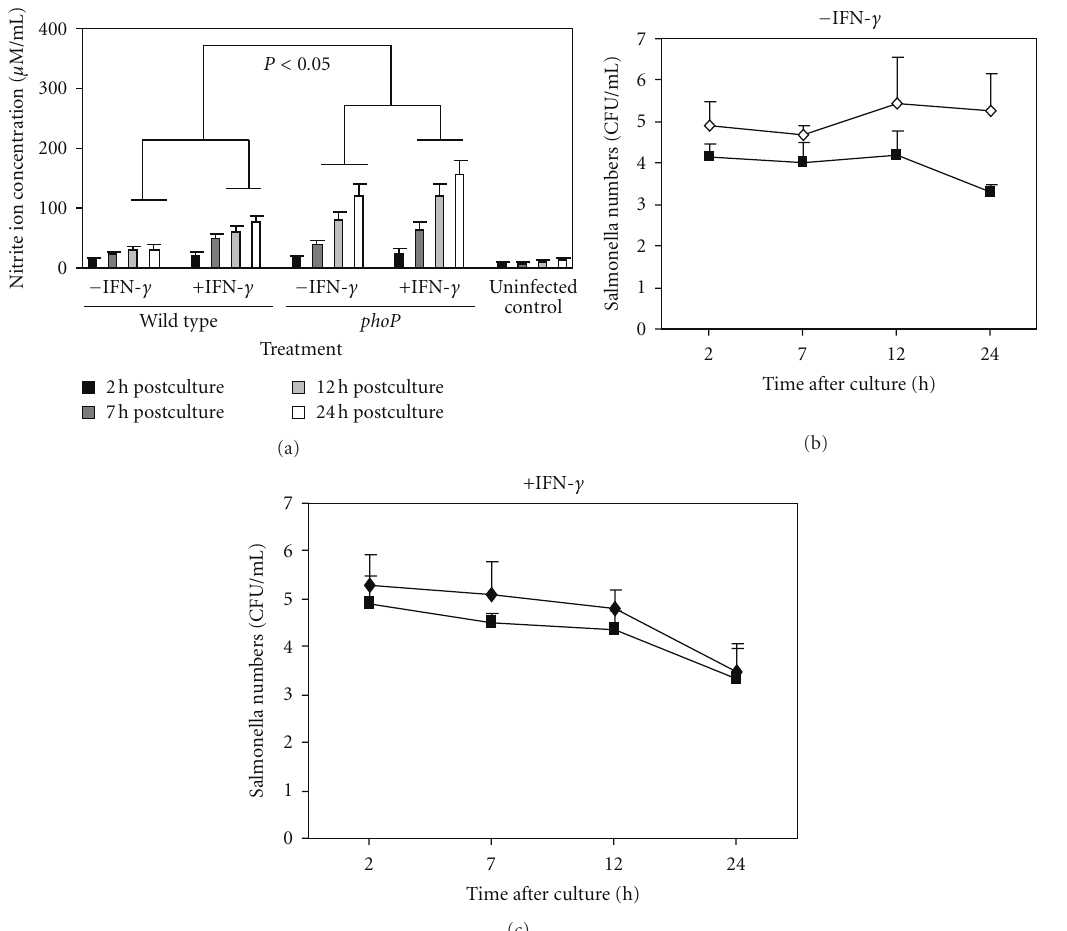
Figure 1: Wild type S. typhimurium 14028 suppresses macrophage nitrite ion production via the phoP regulon but is inhibited by IFN- γ . Histograms show nitrite ion concentrations measured in supernatants from macrophages cultured with 14028 wild type and phoP mutants and uninfected controls and with or without the addition of IFN- γ . ∗ Significant increase ( P < 0.05) in nitrite ion concentration in cell supernatants compared to uninfected controls at equivalent time points. Significant increase ( P < 0.05) in nitrite ion concentrations recovered from macrophage supernatants cultured with 14028 phoP mutants compared to 14028 wild type is also shown. Each point (and standard deviations) is mean values calculated from triplicate cultures replicated on 5 separate